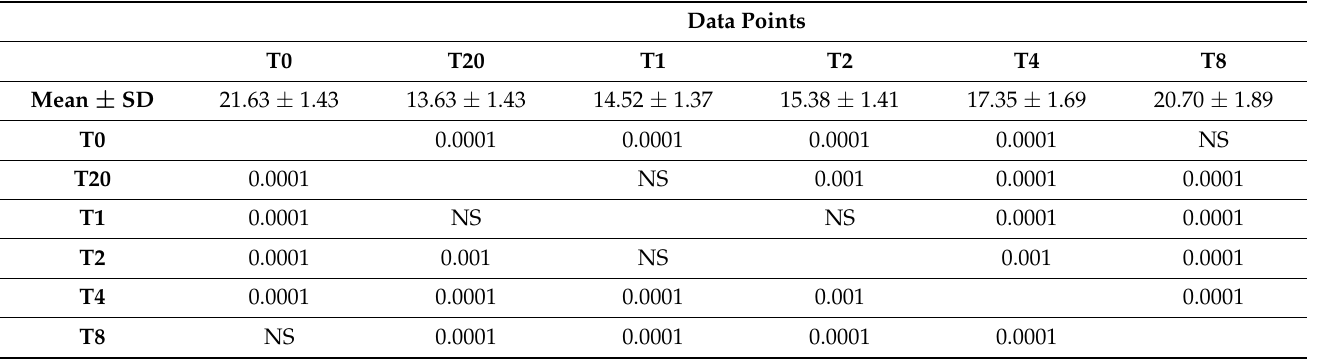
Table 1. Mean values ± standard deviation (SD) of tear secretion recorded using STT-1, expressed in its conventional unit (mm/min) in all data points investigated, together with their statistical